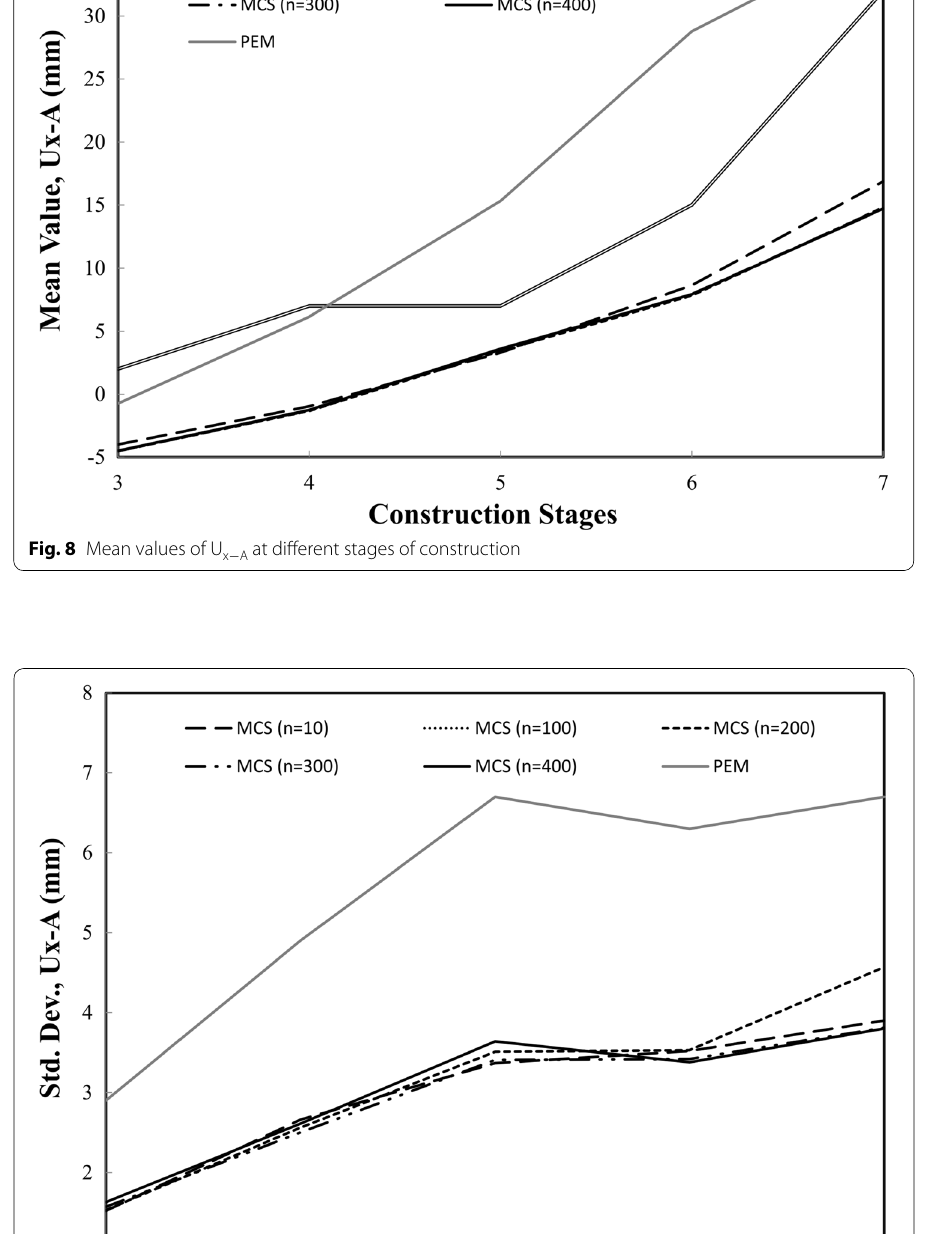
at different stages of − A